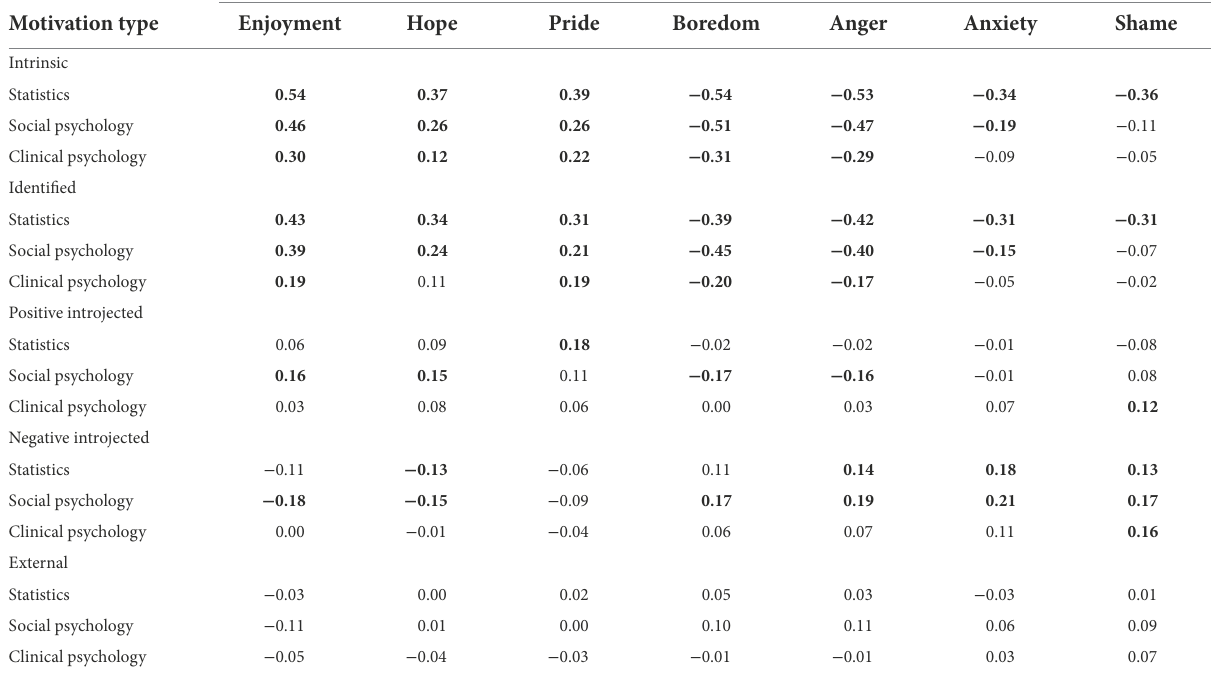
TABLE 7 Correlations between motivation types and academic emotions in corresponding courses ( n = 282).